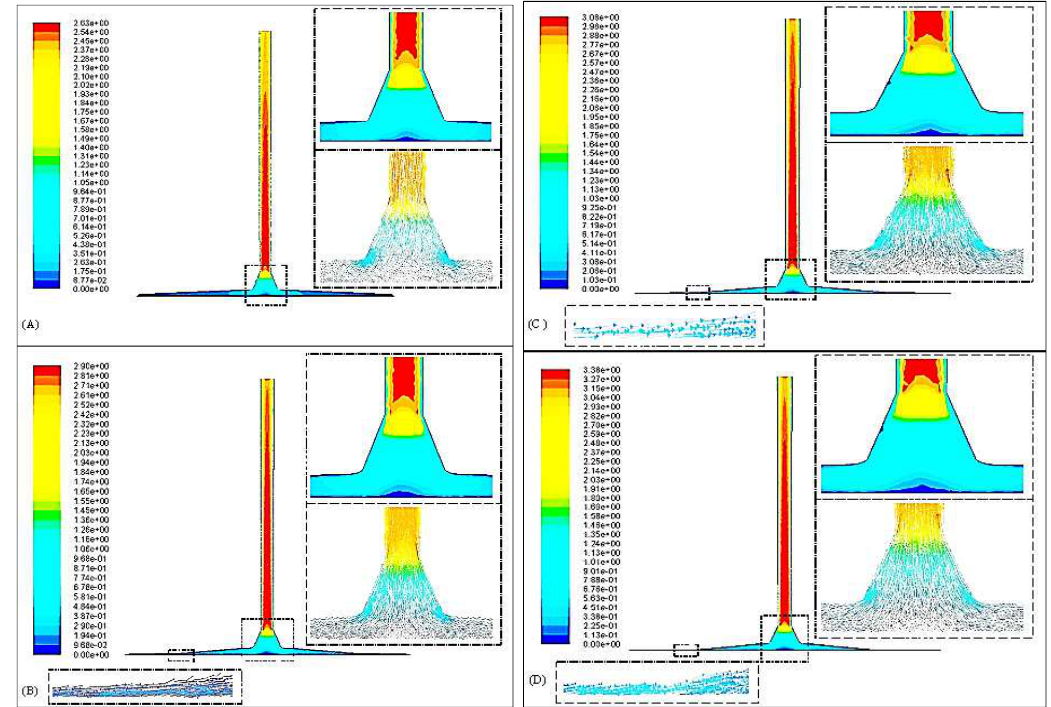
Fig. 13.Contours and vectors of air design velocity (m/s) (A)without reduction area.(B)at h1=3.8cm.( C)at h2=2.6cm. (D) at h3=1.28cm.